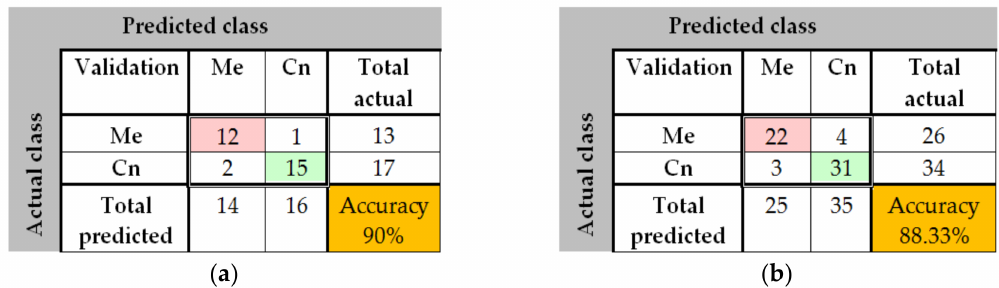
Figure 23. Training progress ResNet-101 CNN.